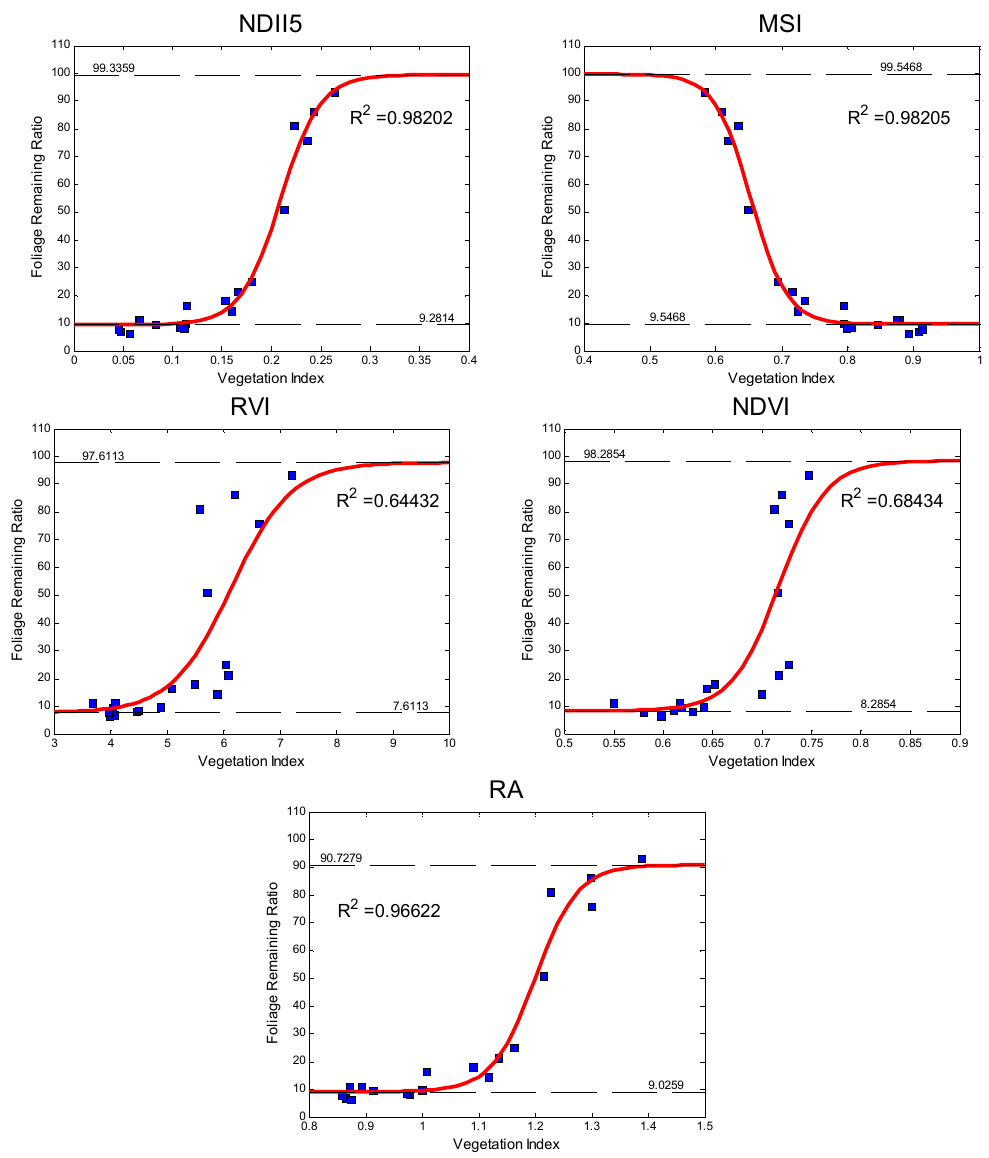
Figure 4. Scatter diagram and fitted curve of foliage remaining ratio and five VIs for 19 sample plots. The regression function of the NDII5 was followed as Equation (2). Its determination coefficient R 2 equaled 0.913.